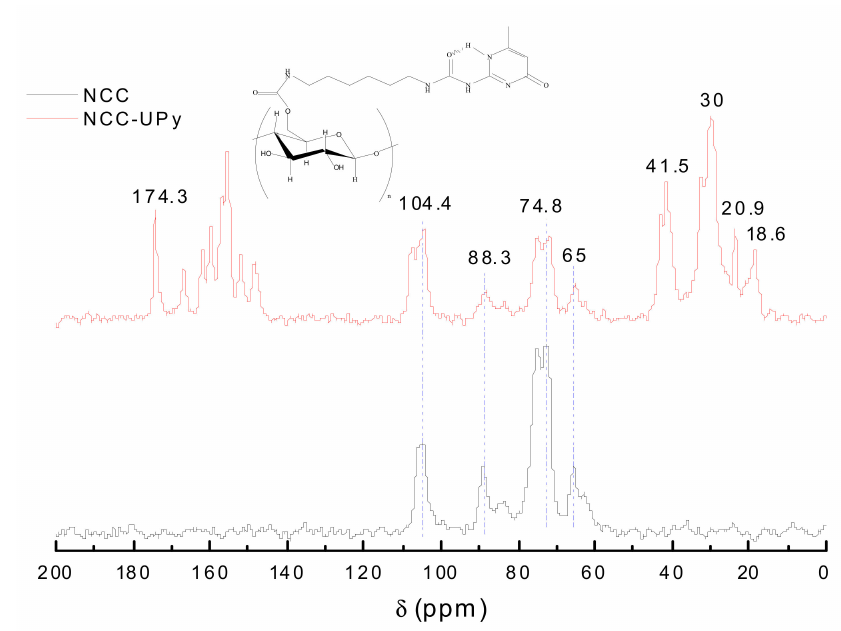
Figure 6. 13 C NMR spectra of NCC and